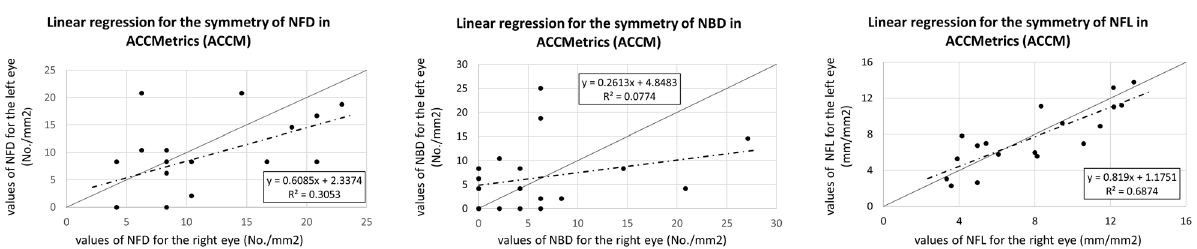
Figure 4. Regression plots of each sub-basal corneal nerve plexus parameters between the right eye and left eye using ACCMetrics (ACCM). Solid in each plot represents the equivalence line while dotted line in each plot represents the Spearman regression line. NFD nerve fiber density, NBD nerve branch density, NFL nerve fiber